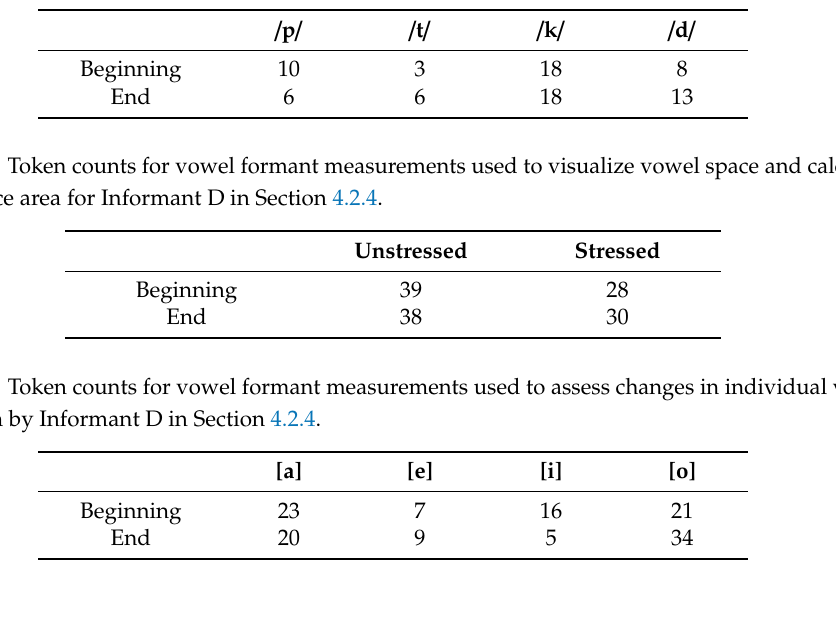
Table A10. Token counts for consonant measurements used to assess changes in production of voiceless and voiced consonants by Informant D in Sections 4.1.1 and 4.1.2.